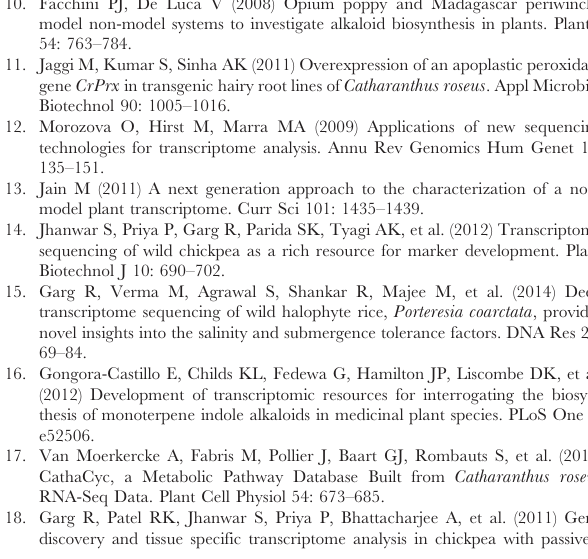
Figure S3 Length distribution of transcripts in the C. roseus transcriptome. Figure S4 GC content distribution in the C. roseus and